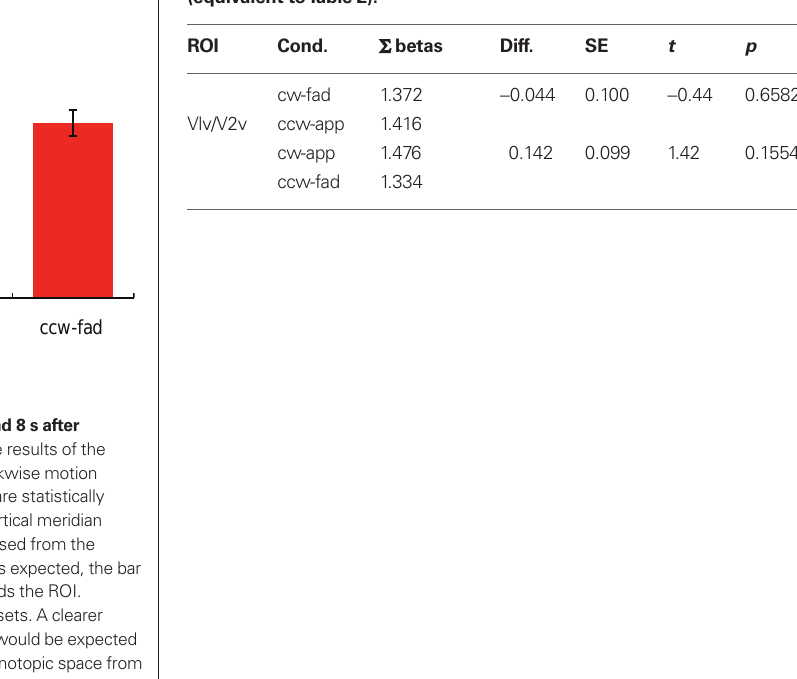
Table S1 | Sum of beta weights, difference and results of t -test (equivalent to Table